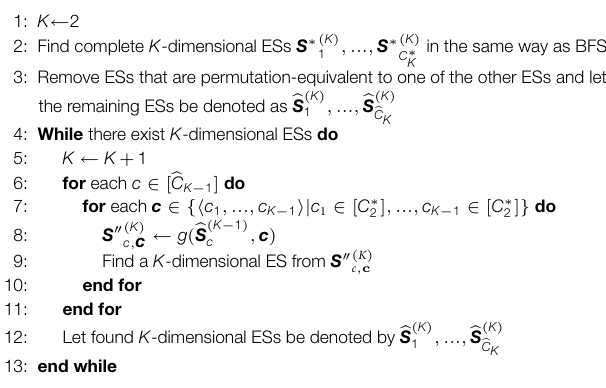
ALGORITHM 2 | Equivalence Structure Incremental Search (ESIS).